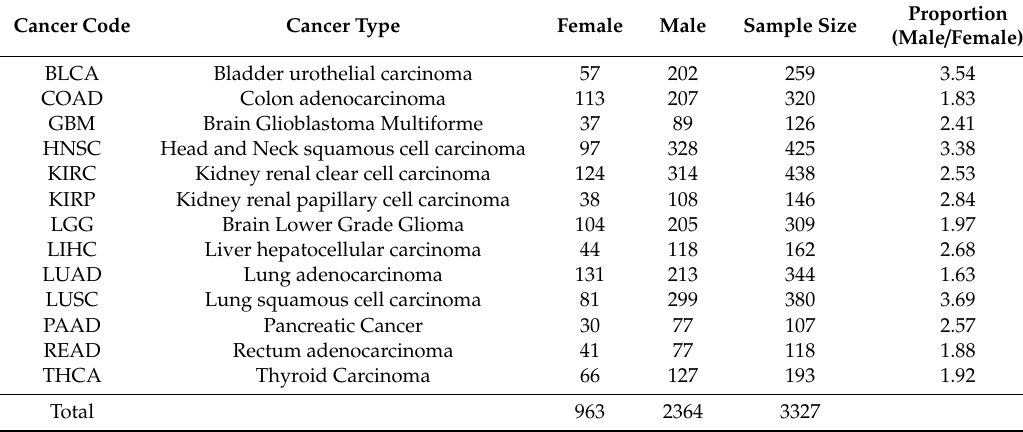
Table 1. Cancer types used in this study.